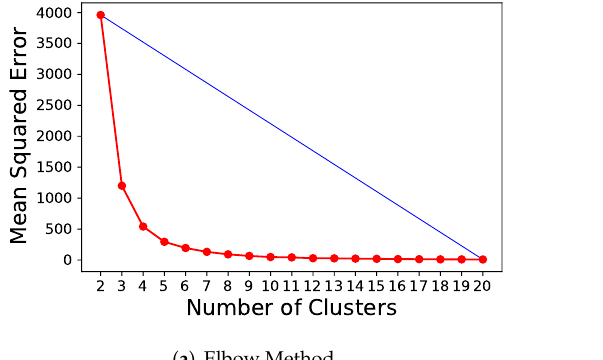
Figure 4. Workload prediction quality metrics for the proposed strategy. Metrics are applied to all access points over a day. ( a ) The more significant is the load on the network, the smaller is the error. ( b ) The model predicts more than 0.80 of the variation for all cases. ( c ) The model error is limited to 7 users per access point.